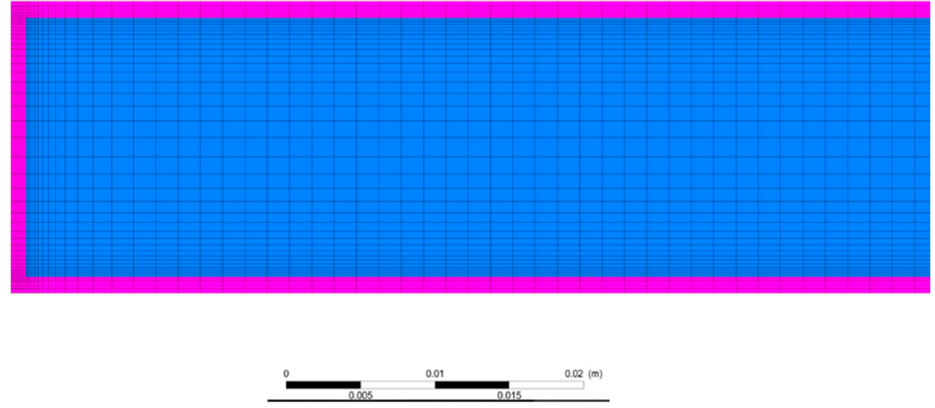
Figure 1. Geometry and mesh of the modeled heat pipe.